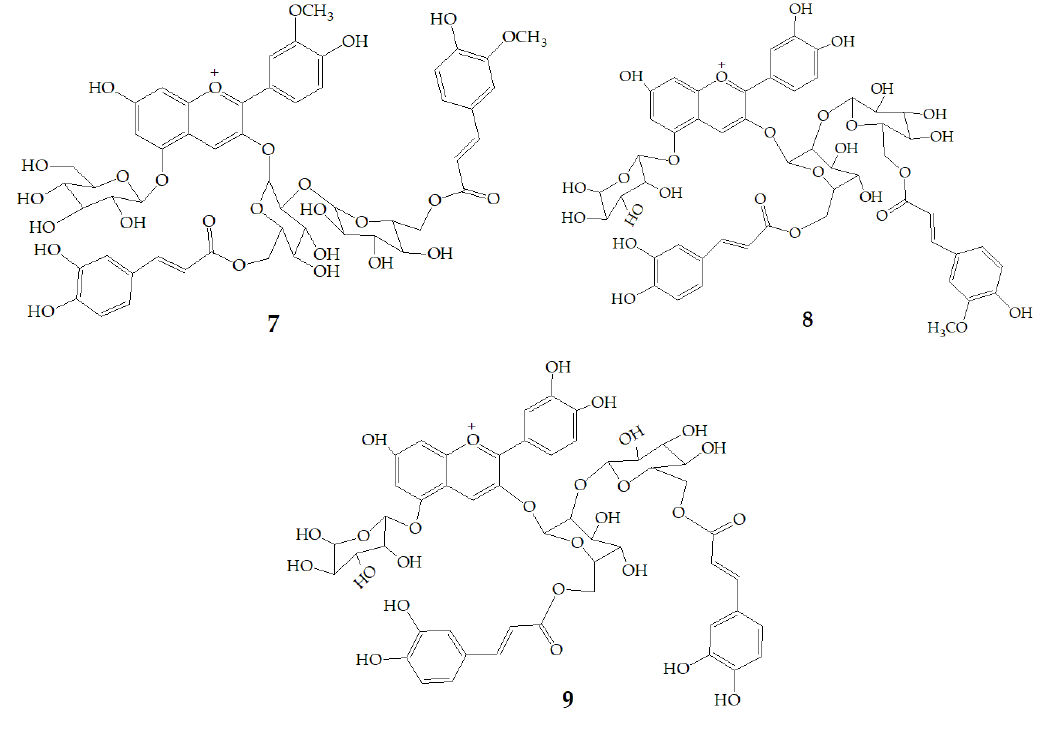
Figure 1. Chemical structures of compound 1 – 9.